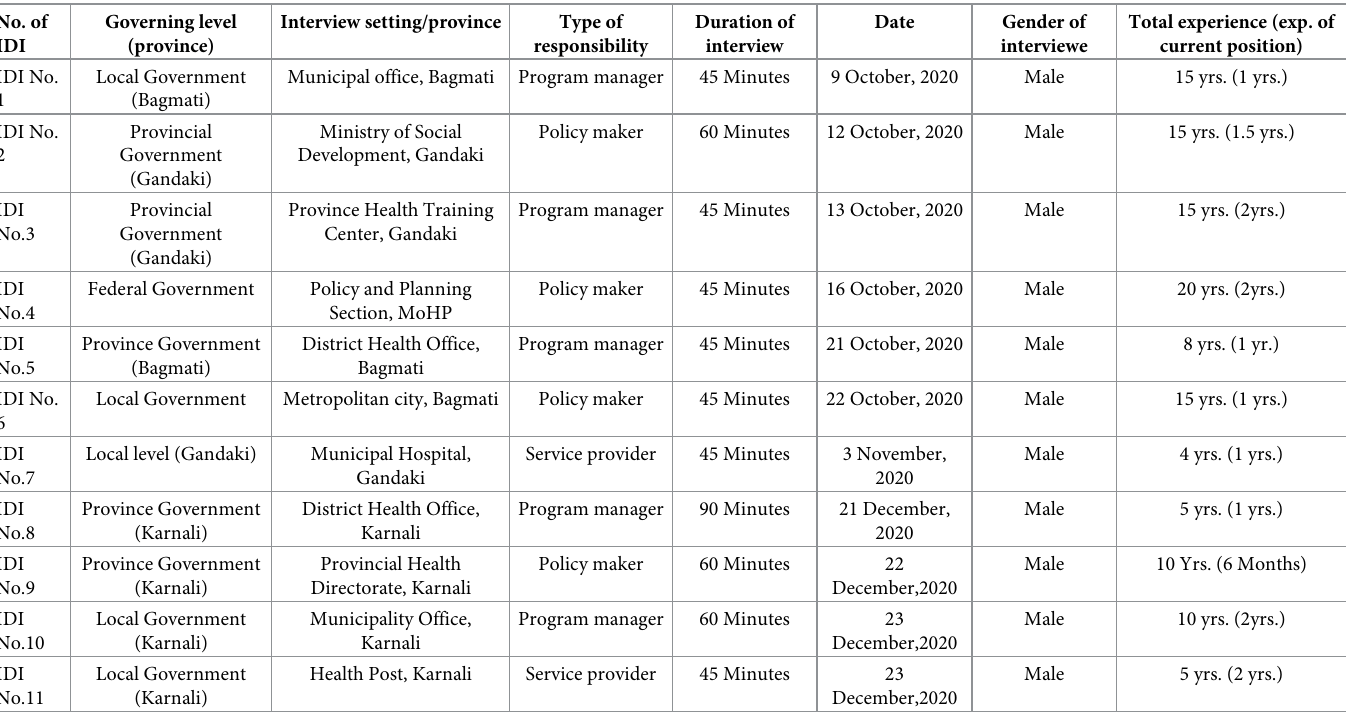
Table 3. Characteristics of IDIs